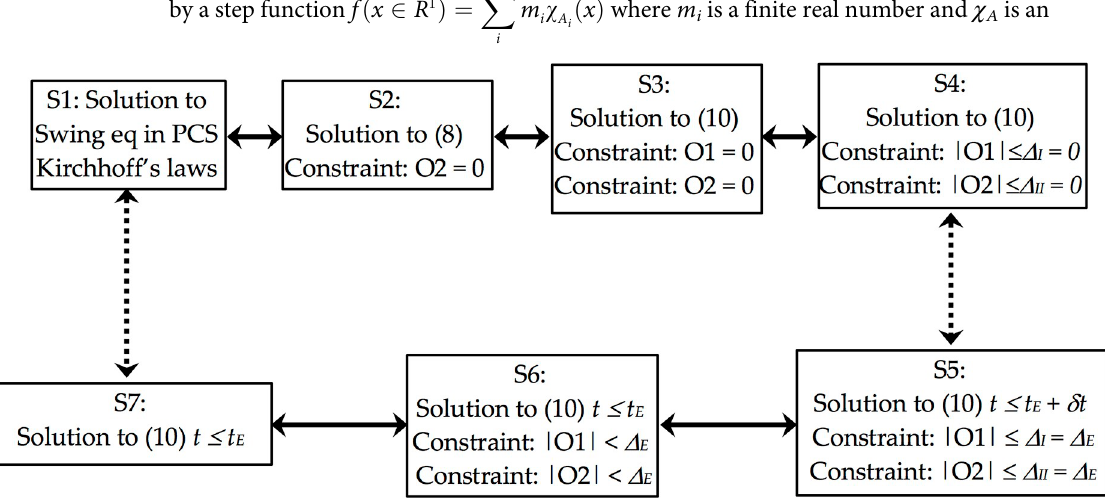
Fig 3. Solutions to various forms of swing equation and its